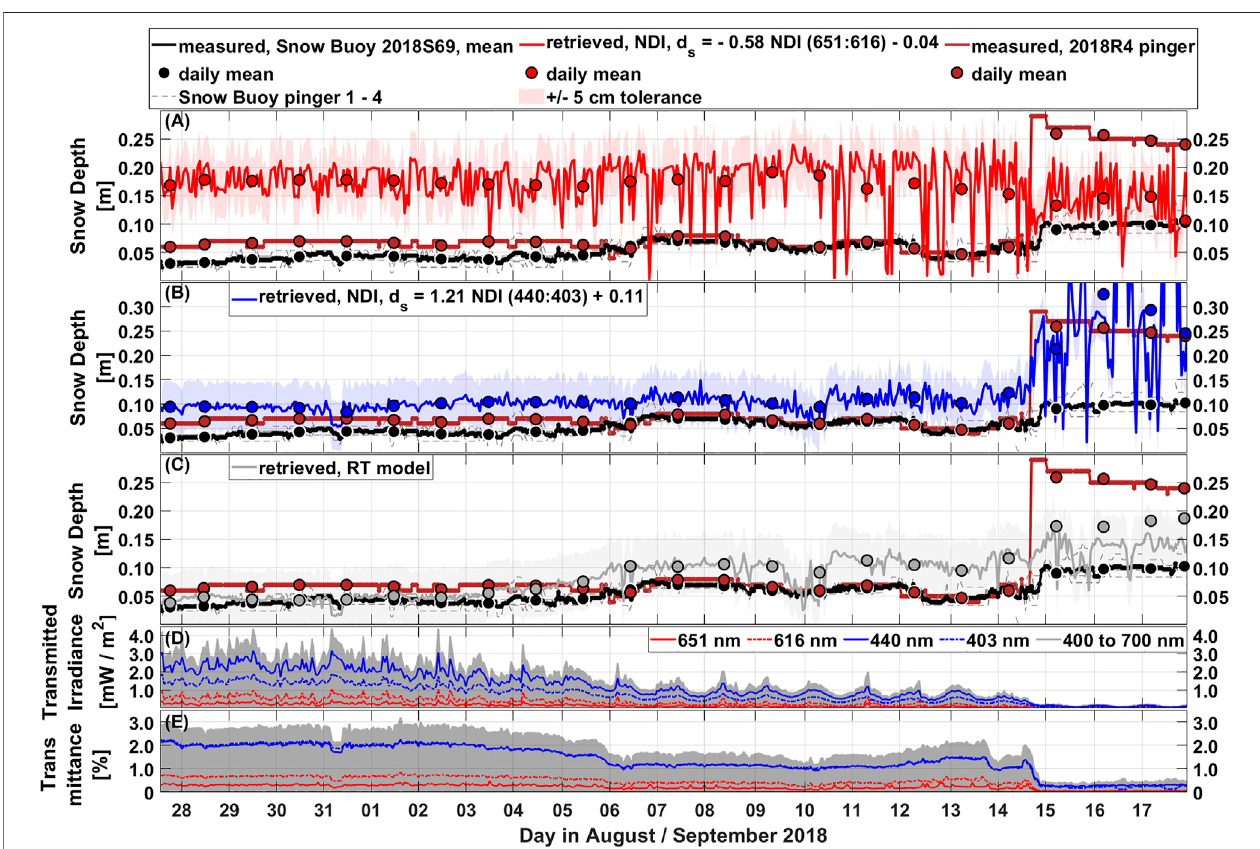
FIGURE 8 | (A – C) Hourly mean snow depths measured by the Snow Buoy 2018S69 (solid black) as obtained on MYI during AO18. Variations in the snow depth due to the four individual ultrasonic snow pingers are indicated by the respective grey dashed lines. The snow depth measured by the snow pinger attached to the radiation station 2018R4 is indicated by the solid brown line. The snow depths retrieved using the NDI method with the wavelength pair 651:616 nm [ (A) , red] and 440: 403 nm [ (B) , blue] are overlaid. The NDIs were calculated from the 2018R4 transmittance. (C) Retrieved snow depths using the RT model with the extinction coef fi cients from Figure 5 (grey). Corresponding daily means (circles) are overlaid. The tolerance of ± 5cm is indicated by the colored shadings. (D) Transmitted irradiance in mW m − 2 and (E) transmittance in % for the wavelengths of the NDI method and integrated from 400 to 700 nm as used in the RT model.